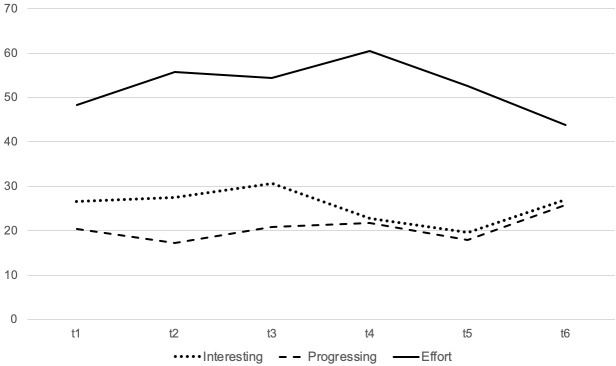
Mean scores of the CSSM items for each measurement point.